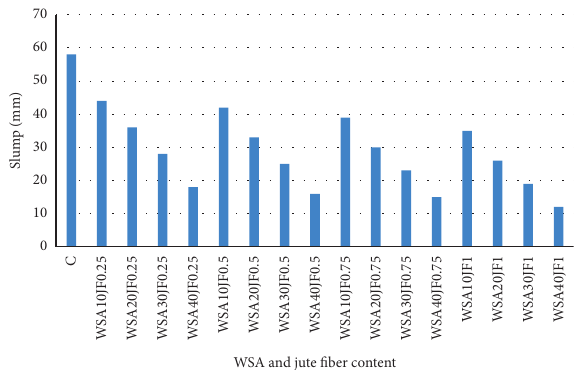
Figure 3: Workability of mixtures containing WSA and jute fiber.